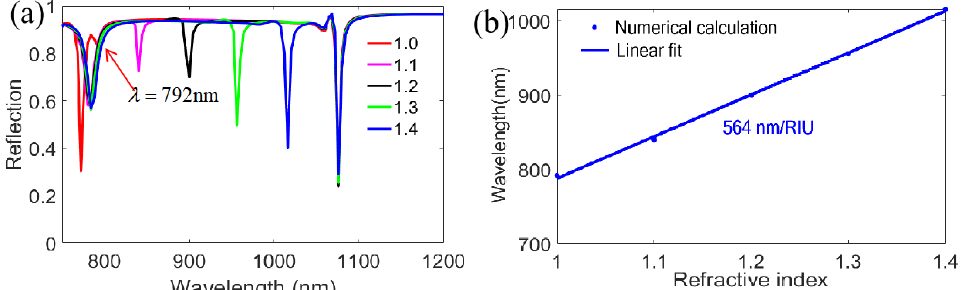
Figure 4. Investigation of sensing performance for TM polarization on the bottom with 10° incident angle. ( a ) Reflection spectra of different RIs; ( b ) Linear response of the resonant wavelength for the little reflection dip (at λ = 792 nm in air).